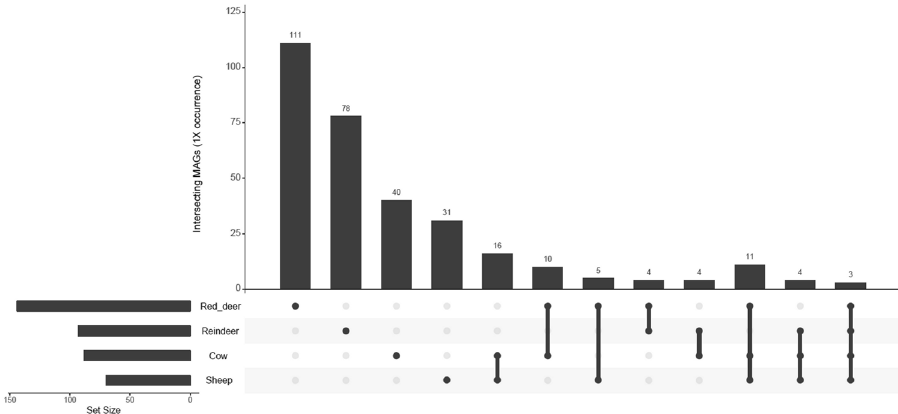
Figure 3. UpSetR graph showing the number of shared microbial genomes at average ×1 coverage (after sub- sampling to equal depth) within four ruminant